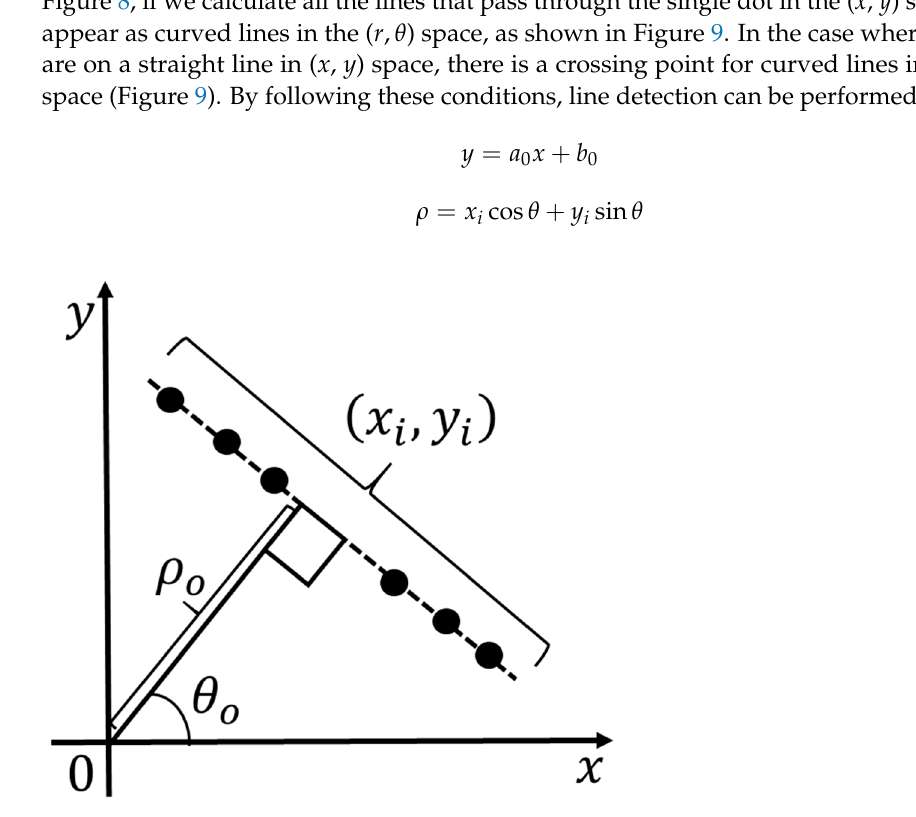
Figure 9. (x, y) space to ( 𝑟,𝜃 ) space conversion.